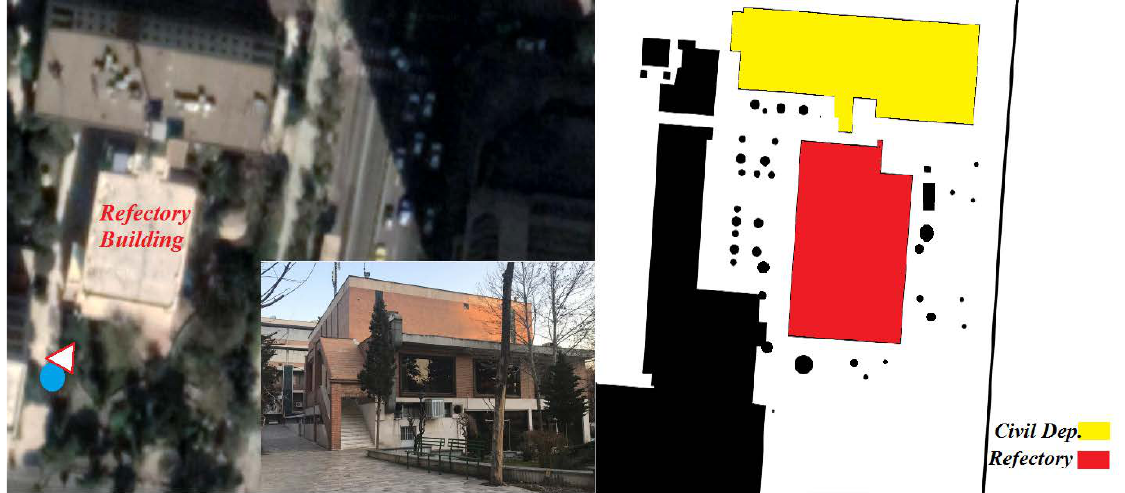
Figure 18. A cropped satellite view of the civil department and the refectory buildings augmented with a terrestrial image captured from the refectory building ( left ). The available surveying map of the building and their surrounding objects ( right ).